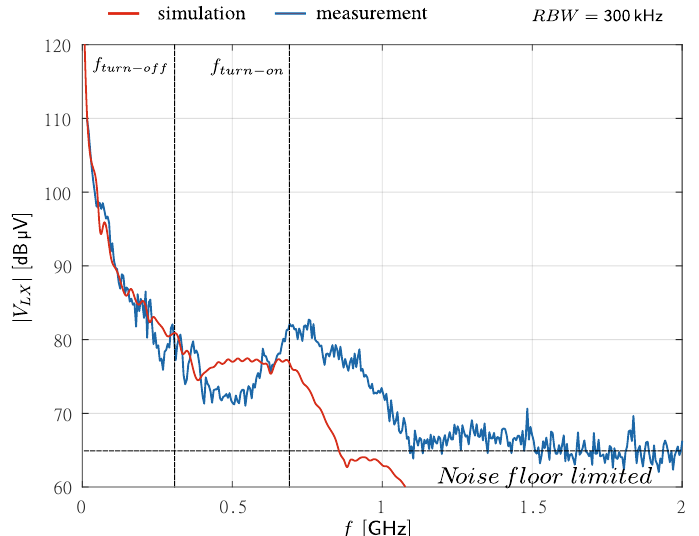
Figure 11. Simulation and measurement results of the frequency spectrum of the phase node